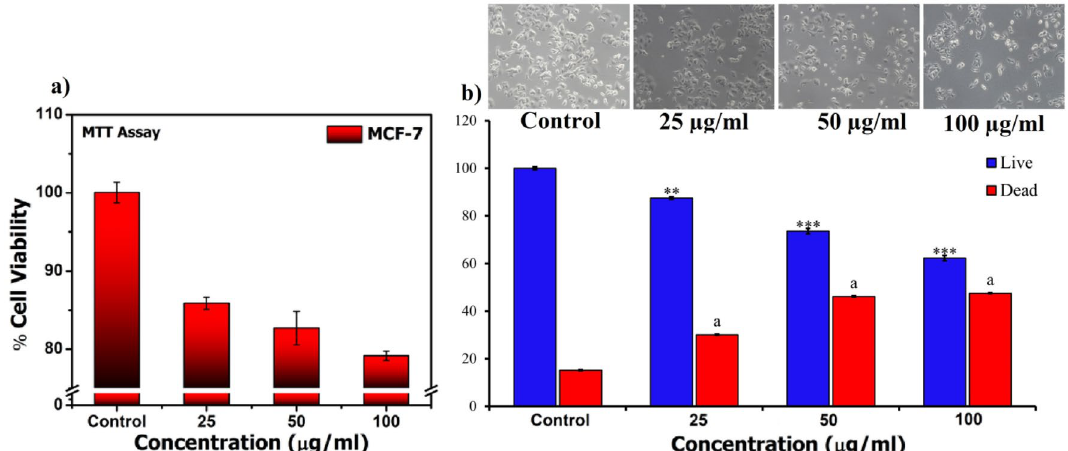
Figure 4. ( a ) Results of cell viability assay of SAPE on MCF-7 cells measured by MTT based method. ( b ) Cell viability assay of SAPE at 48 h on cells of MCF-7 with doses of (25, 50 and 100 µg/mL) or with 0.1% DMSO as the vehicle control using trypan blue exclusion method. Graphs are presented in terms of mean ± SEM percentage of live and dead cells of the three independent sets. Values were significant at * P ≤ 0.05, ** P ≤ 0.01 and *** P ≤ 0.001 as compared to